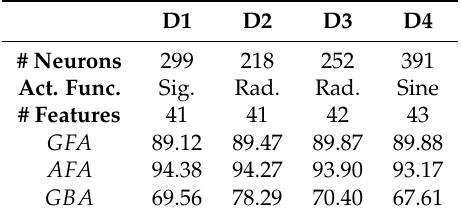
Table 3. Results for the best Global Flow Accuracy ( GFA ) pareto-optimal solution. D1